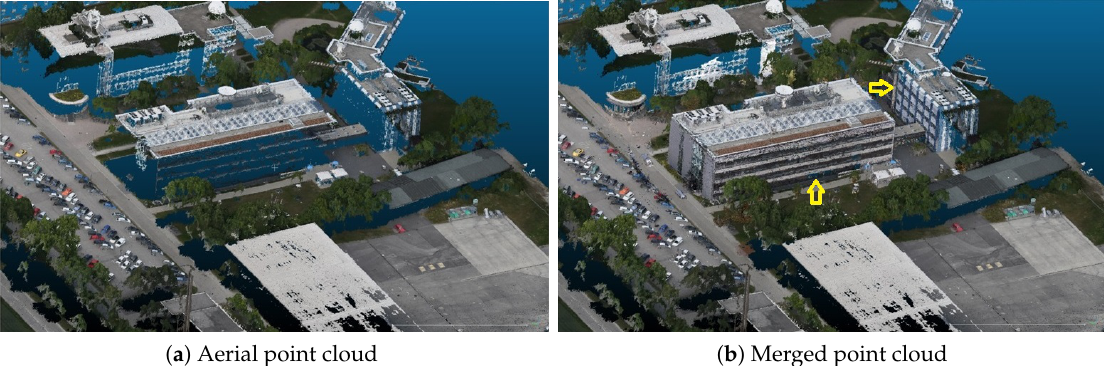
Figure 18. Comparison of the dense point clouds for ( a ) only aerial images and ( b ) additional registered nadir and oblique UAV images of the EOC dataset. The combination of aerial and UAV images can enrich 3D models for more details and add facades to